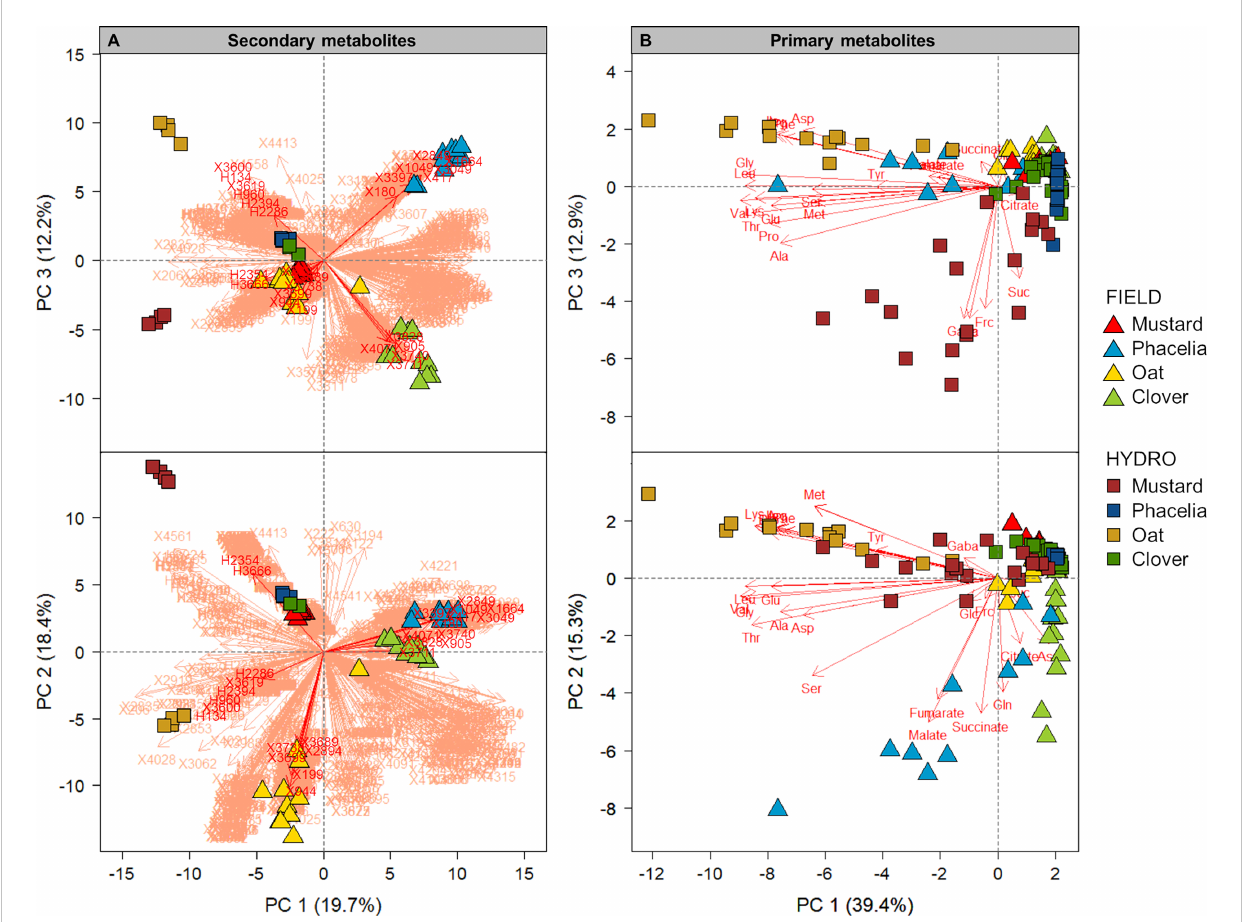
FIGURE 3 Diversity of primary and secondary metabolites in root exudates of mustard, phacelia, oat and clover grown in the fi eld (FIELD) or hydroponically (HYDRO). Principal component analysis of secondary (A) and primary (B) metabolites. For primary metabolites, recovery as given in Table 1 was used as input data and scaled prior to PCA analysis; for secondary metabolites a binary presence/absence matrix of semi-polar features detected by an untargeted approach was imputed without scaling. Plots show the principal components (PC) 1, 2 and 3 and the variance explained by them in brackets. Red arrows represent eigenvectors of the covariance matrices of primary or secondary metabolite data. In Figure 3A the eigenvectors of level 1-3-annotated compounds mentioned in section 3.2 are